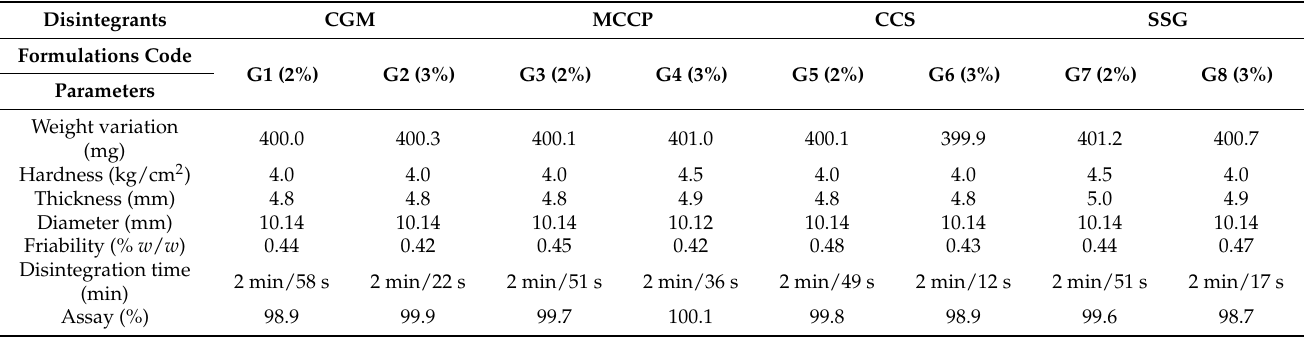
Table 10. Evaluation of tablets using different disintegrating agents.